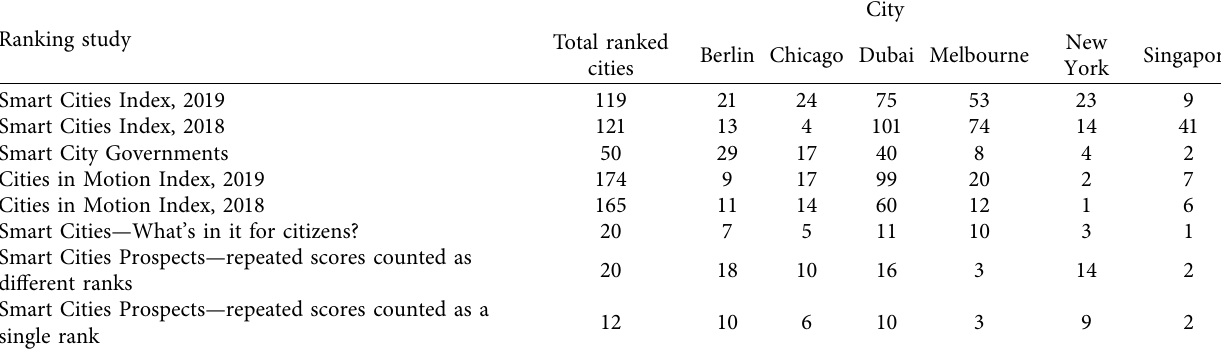
Table 3: Summary of ranking of the 6 common cities in all the 7 ranking studies